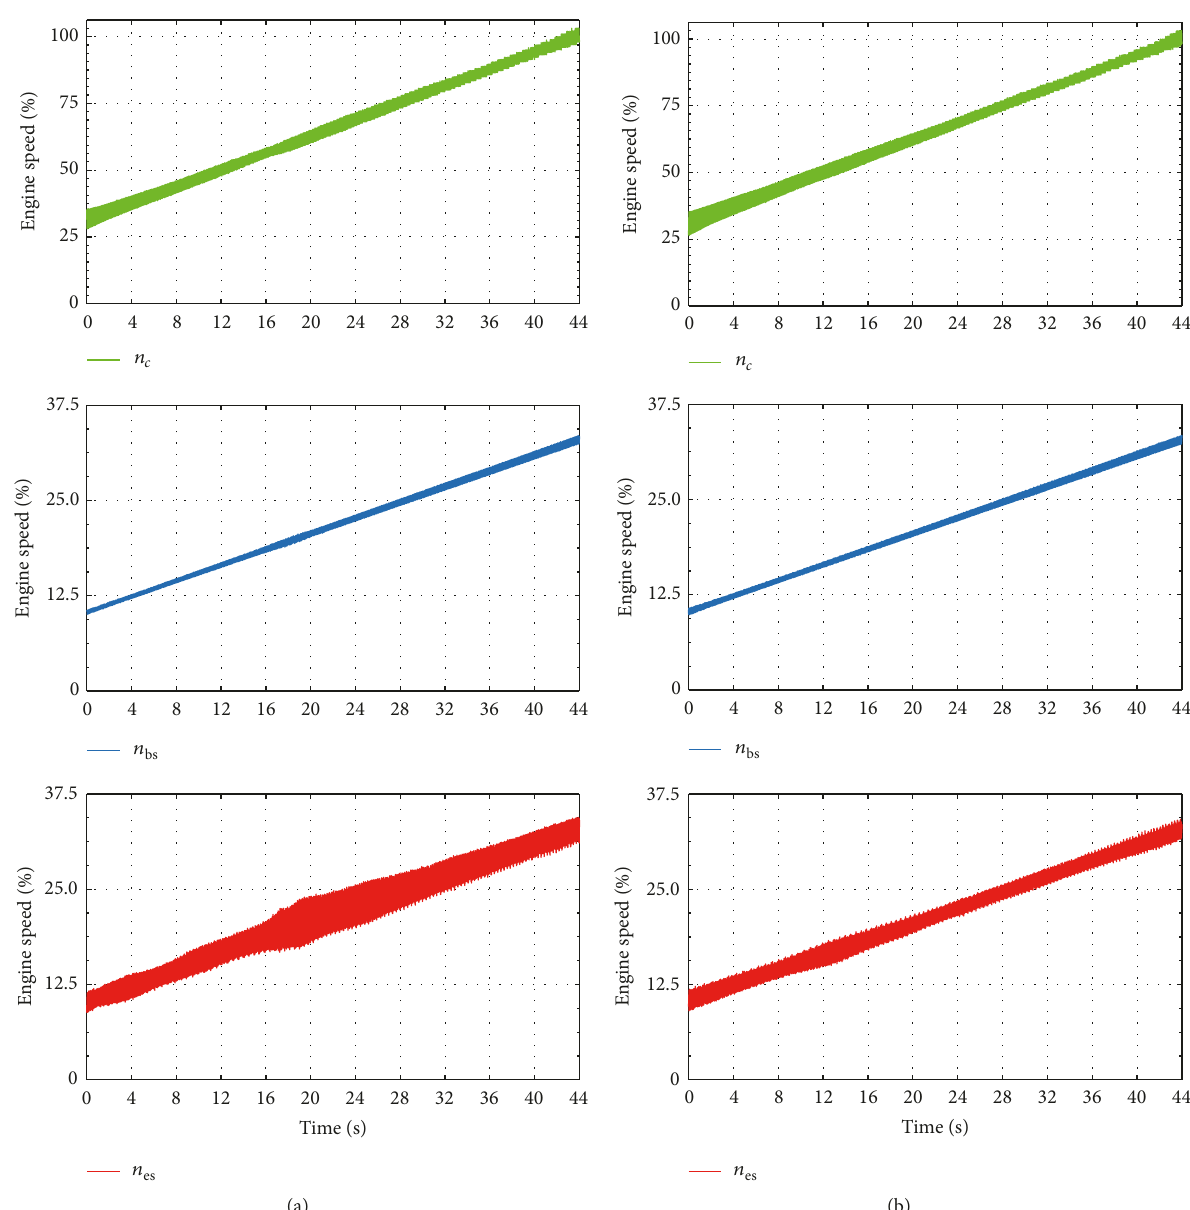
Figure 7: Time data of the normalized velocity signals acquired during a run-up test: (a) 45 Sh rubber elements and (b) 70 Sh rubber elements.